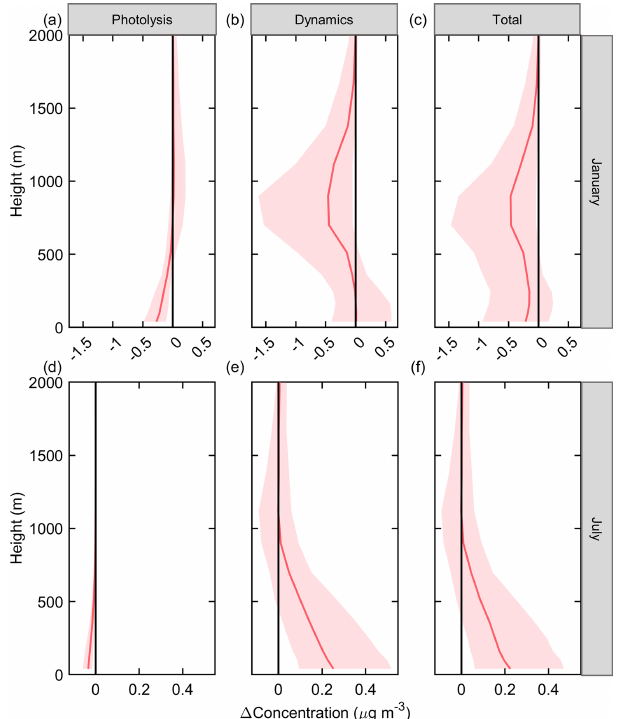
Figure 7. Vertical profile of nitrate concentration change to ADEs in the JJJ region at noontime in January (a, b, c) and July (d, e, f) .